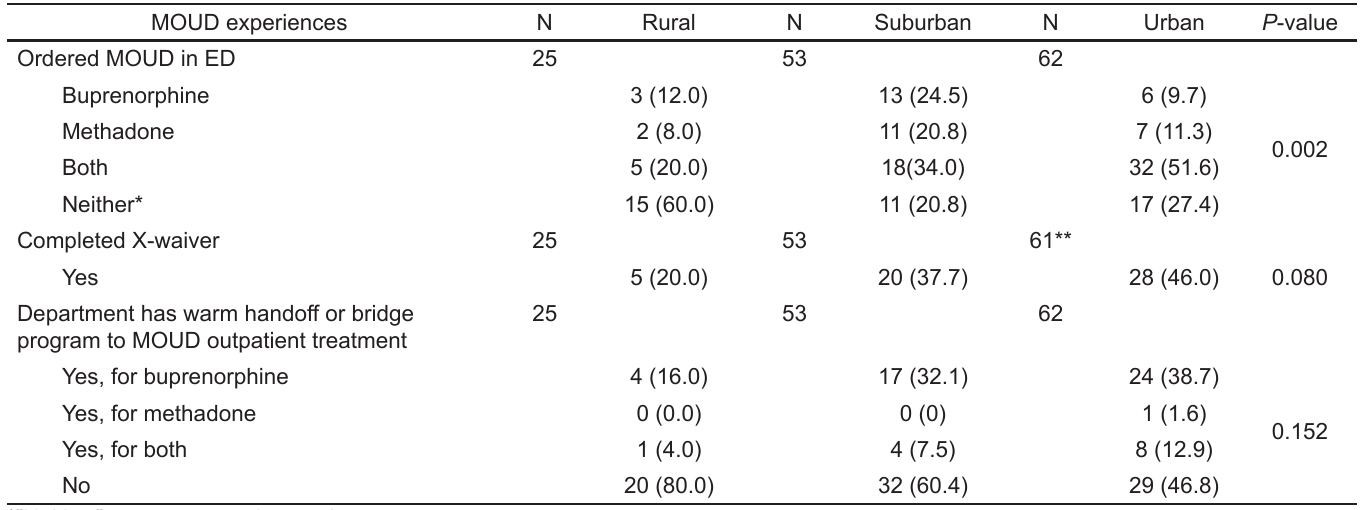
*”Neither” was not an option on the survey.